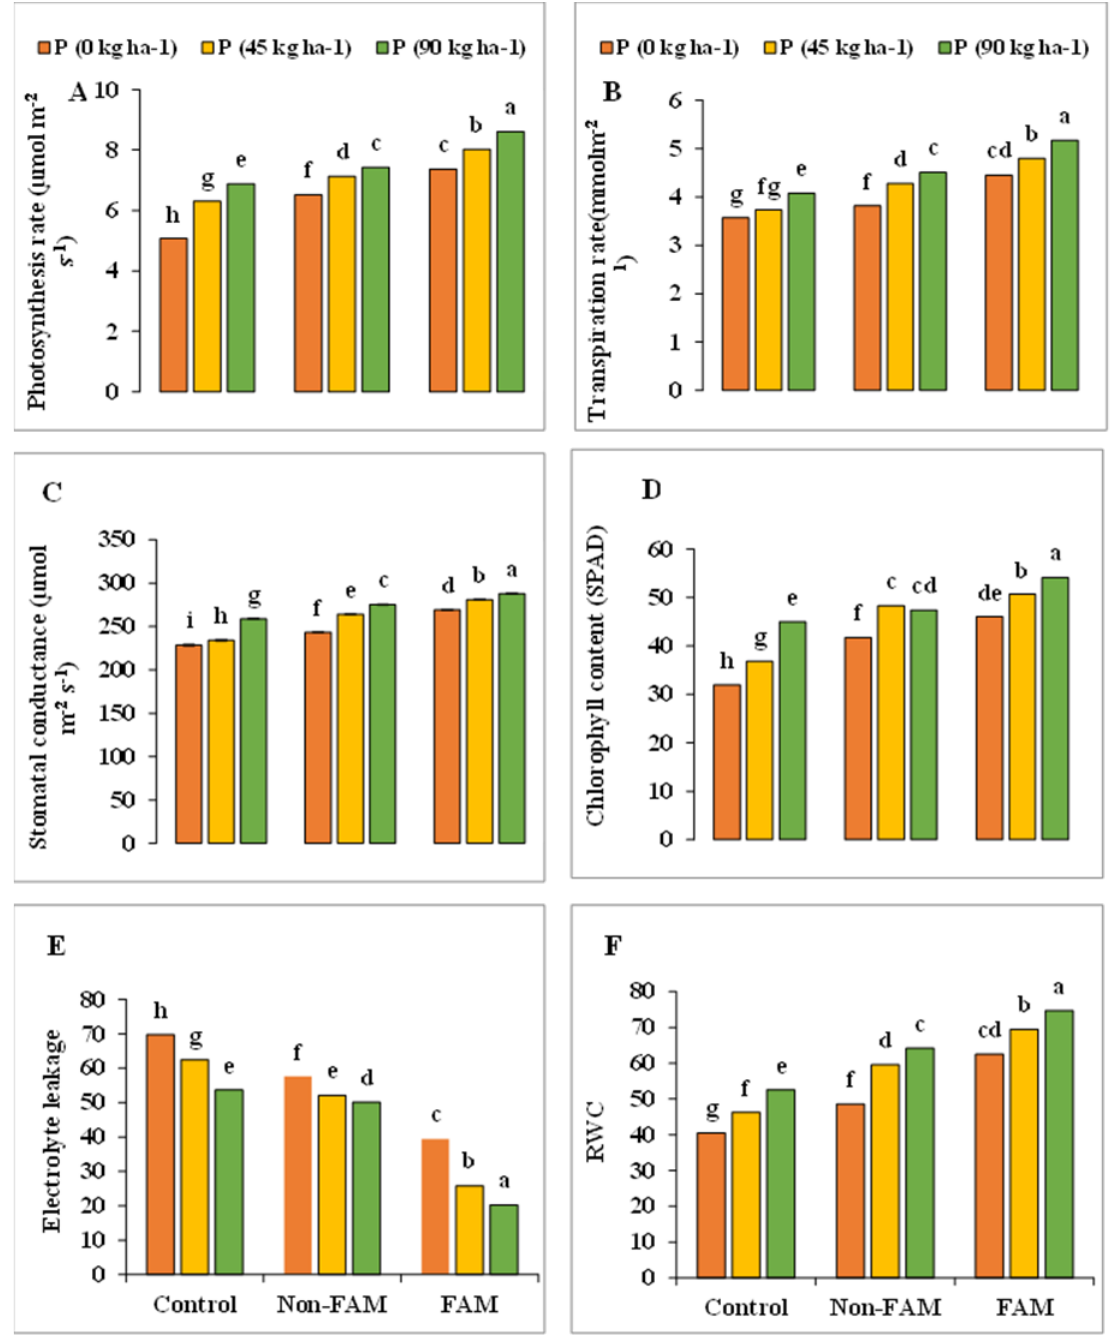
Figure 3. Combined use of fermented/non-fermented animal manure and phosphorus fertilizer on physiological parameters of wheat. ( A ) Photosynthesis, ( B ) transpiration, ( C ) stomatal conductance, ( D ) chlorophyll, ( E ) electrolyte leakage and ( F ) relative water content. Columns with different letters are significantly different from one another at a level of significance of p < 5%.